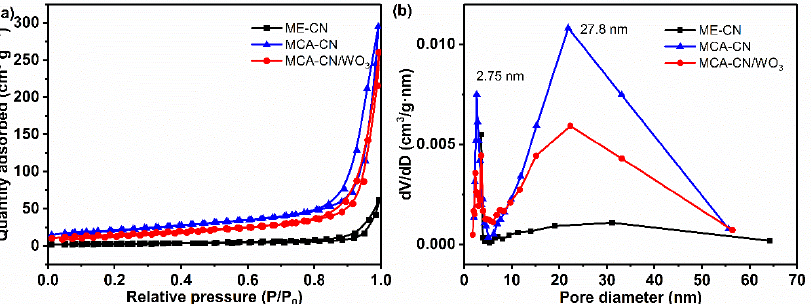
Figure 5. ( a ) N 2 adsorption/desorption isotherm of ME-CN, MCA-CN and MCA-CN/WO 3 and ( b ) pore size distribution curves of ME-CN, MCA-CN and MCA-CN/WO 3 . ( b ) pore size distribution curves of ME-CN, MCA-CN and MCA-CN/WO 3